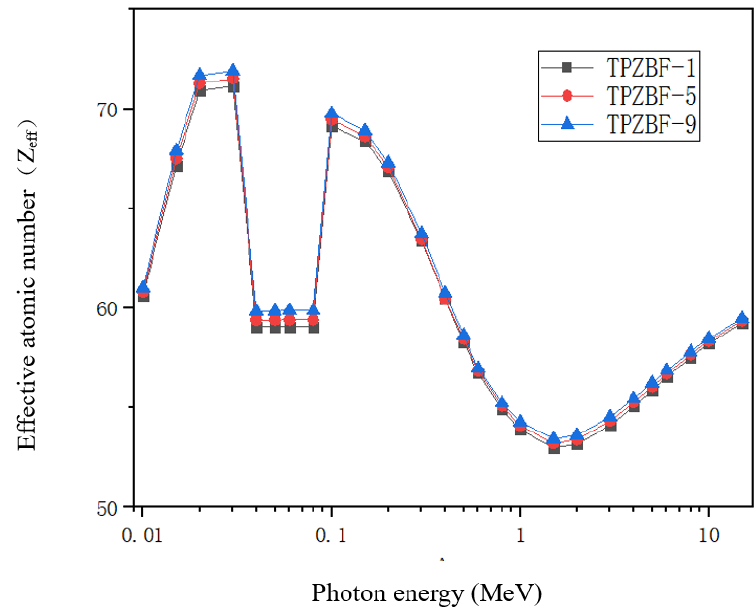
Figure 7. Z eff value of TPZBF glass system.